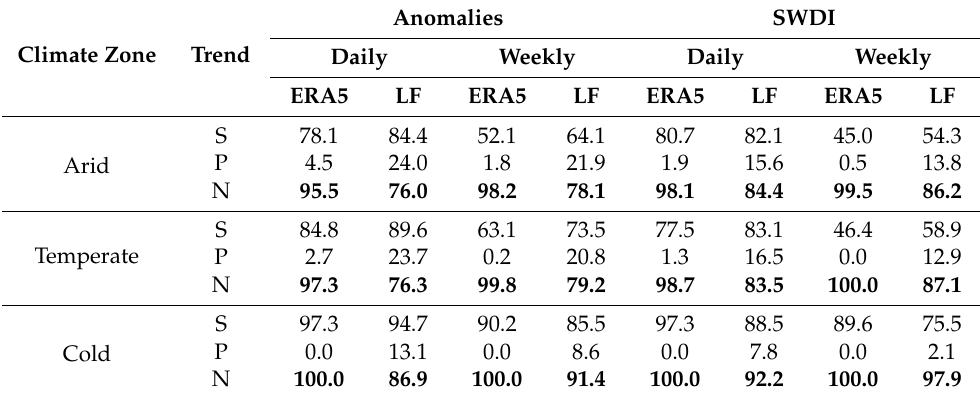
Table 2. Percentage of significant (S), positive (P), and negative (N) trends at daily and weekly scales and by climate zone (Köppen-Geiger classification). Maximum trend percentage values are in bold. Anomalies SWDI Climate Zone Trend Daily Weekly Daily Weekly ERA5 Arid